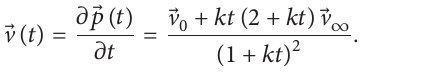
models are plotted side by side in Figure 3. All balls are launched at an 45 ∘ angle at 50 m/s on a windless earthly day ( 𝑔 = 9.81 m/s 2 ). The different drag models are calibrated to respect the respective ball’s terminal velocities (except for the dragless model, which always has an infinite terminal